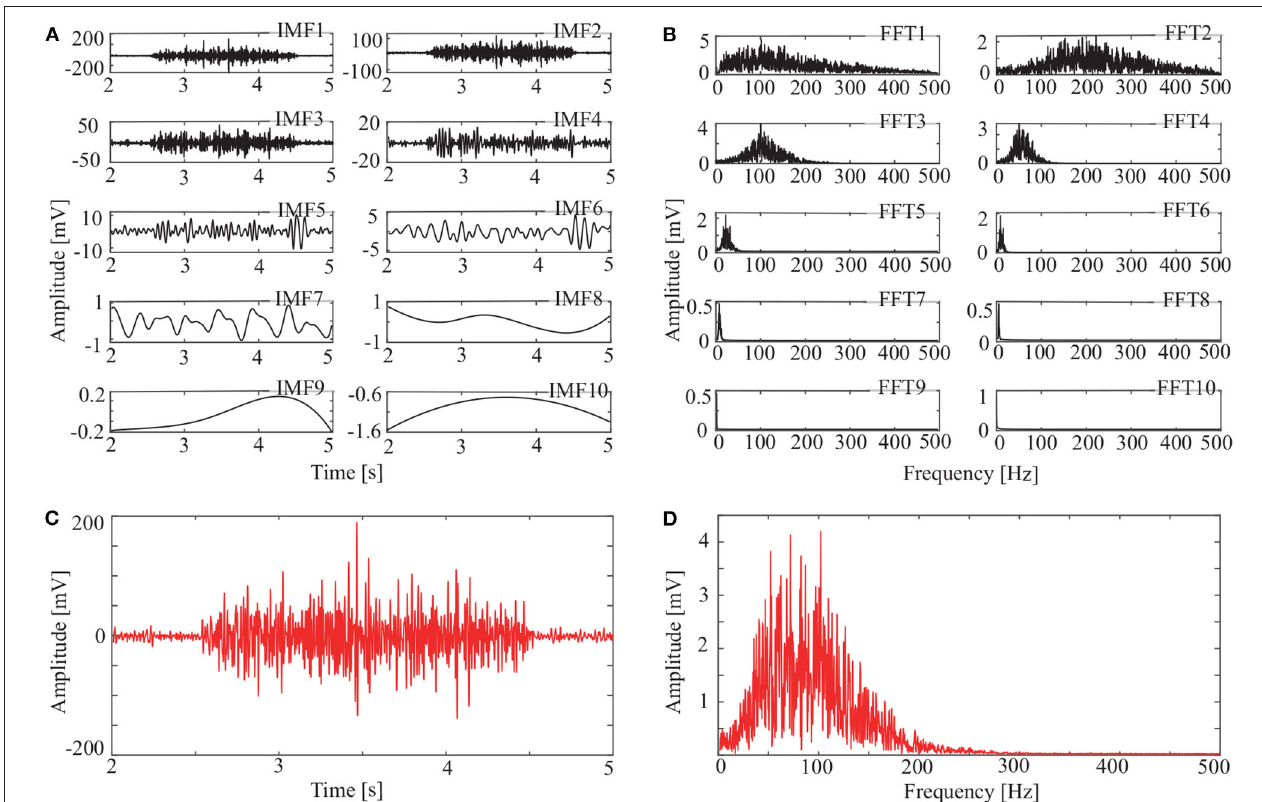
FIGURE 4 | IMFs and spectrums using CEEMD: (A) IMFs of signal in Figure 3C , (B) Corresponding FFTs, (C) Reconstructed signal, and (D) Spectrum of reconstructed